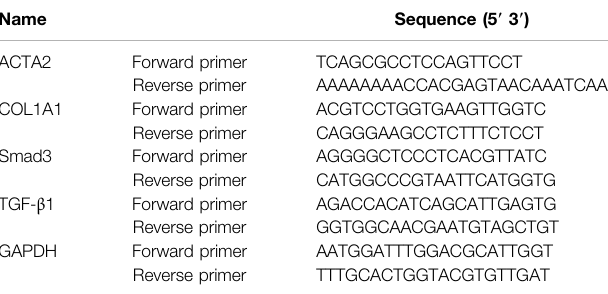
TABLE 2 | Mouse primers for quantitative real-time PCR analysis.